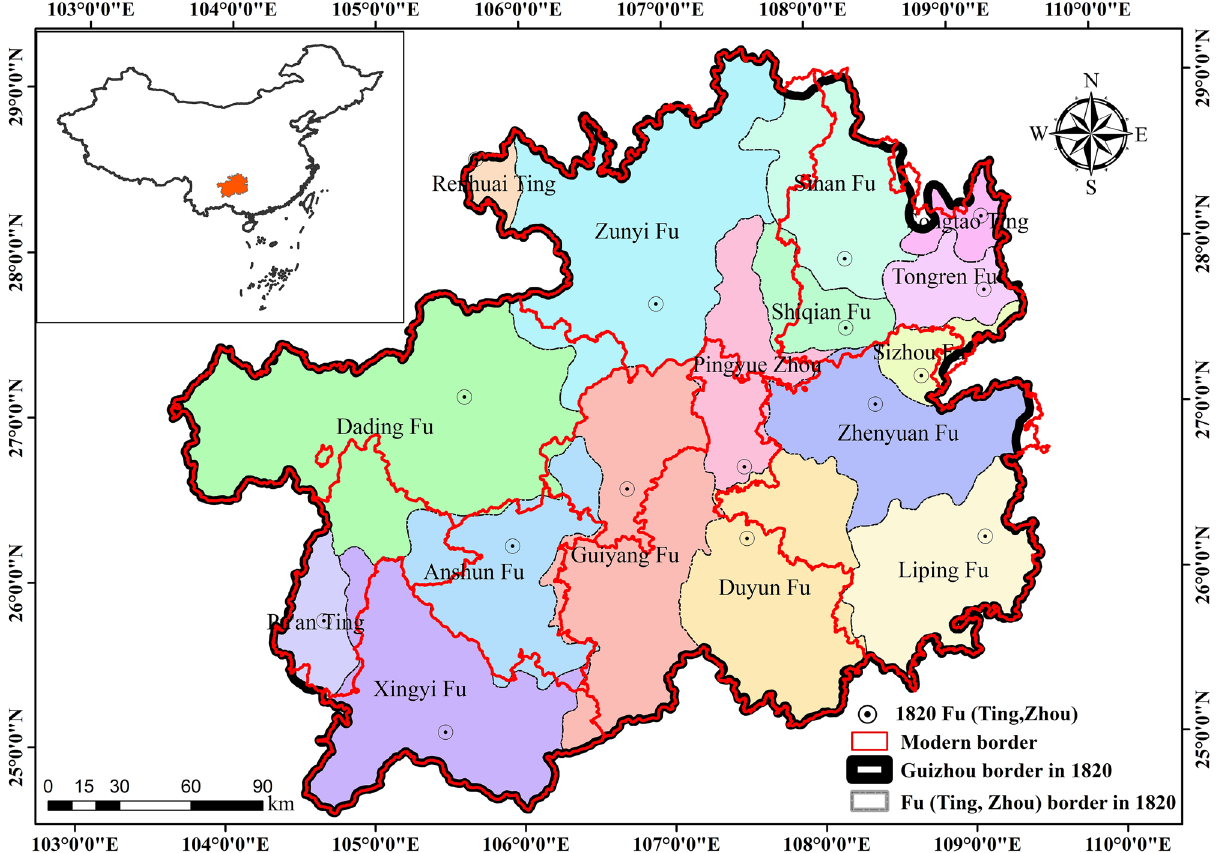
Figure 1. Location of the study area, ancient and modern administrative boundaries(map created using ArcGIS